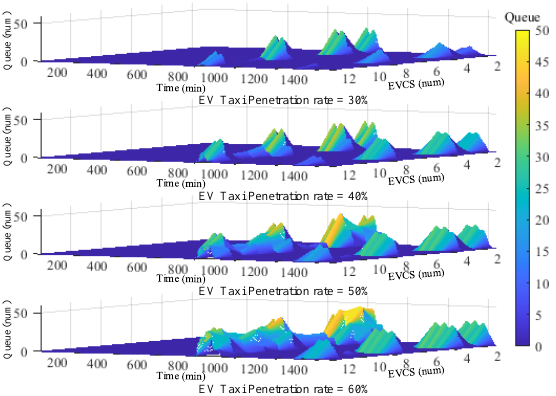
EV Taxi Penetration rate = 60% Figure 8. Longest queuing comparison under different Figure 8. Longest queuing comparison under different ETPR.